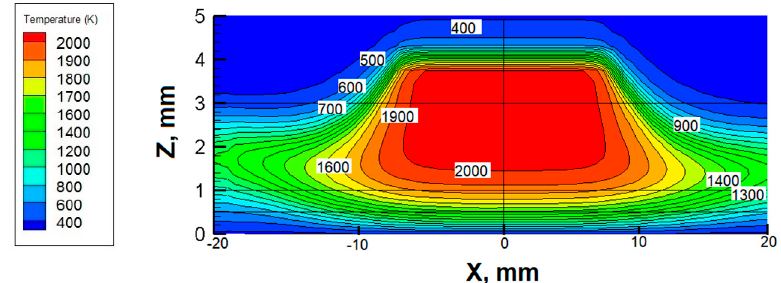
Figure 5. Temperature contours at ω = 600 rpm in X - Z plane (unit: K).